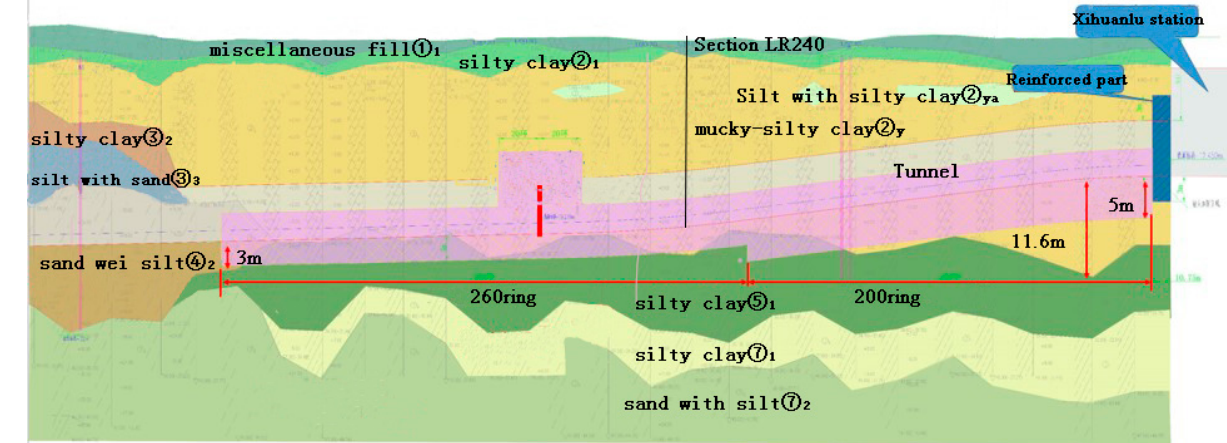
Figure 1. Schematic diagram of stratum grid division. Figure 1. Geological profile.